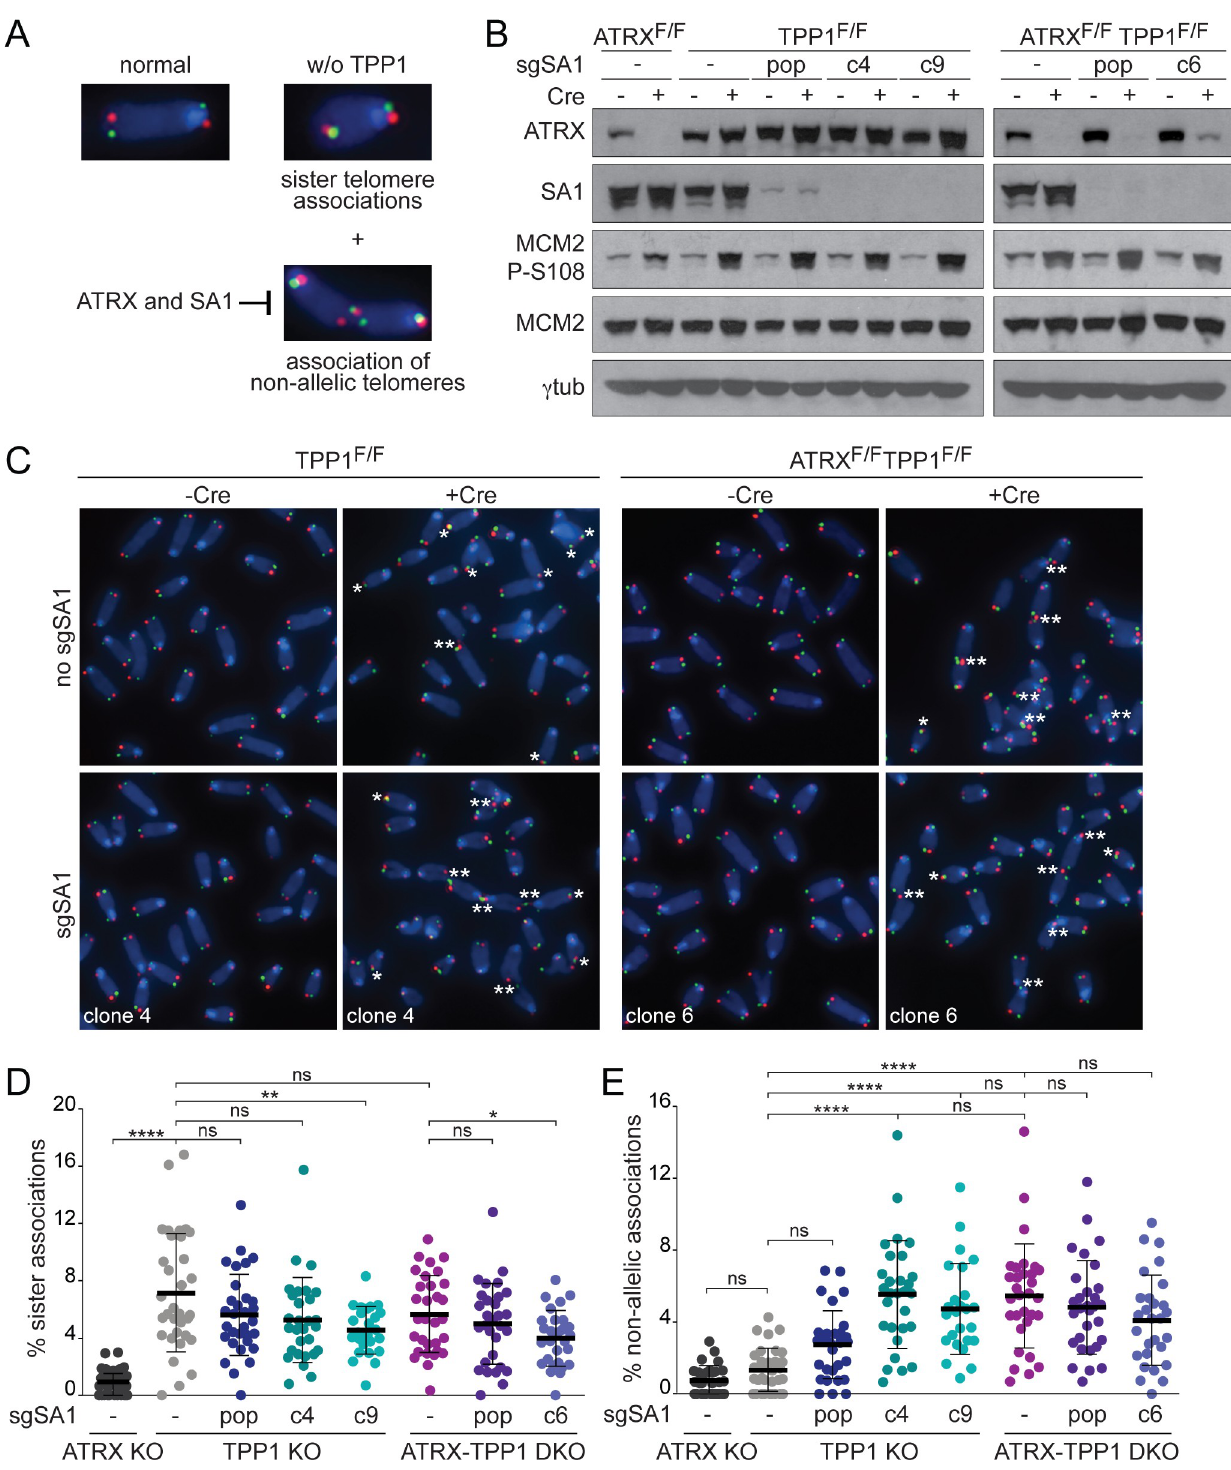
Fig 3. Telomere cohesion defects promote interactions between nonallelic telomeres. (A) Representative images of CO-FISH staining on a normal metaphase chromosome, the sister telomere associations frequently observed after deletion of TPP1, and the occasional nonallelic telomere associations observed after TPP1 loss that are suppressed by ATRX- and SA1-mediated telomere cohesion. (B) Immunoblots showing Cre-mediated deletion of ATRX (4 days) and SA1 targeting by CRISPR/Cas9 in the indicated MEFs. pop, an SA1-targeted population of cells; c#, SA1 KO clone. Phosphorylation of MCM2 S108 in TPP1-deficient cells is representative of DNA damage signaling and efficient deletion of TPP1. γ tubulin serves as a loading control. (C)